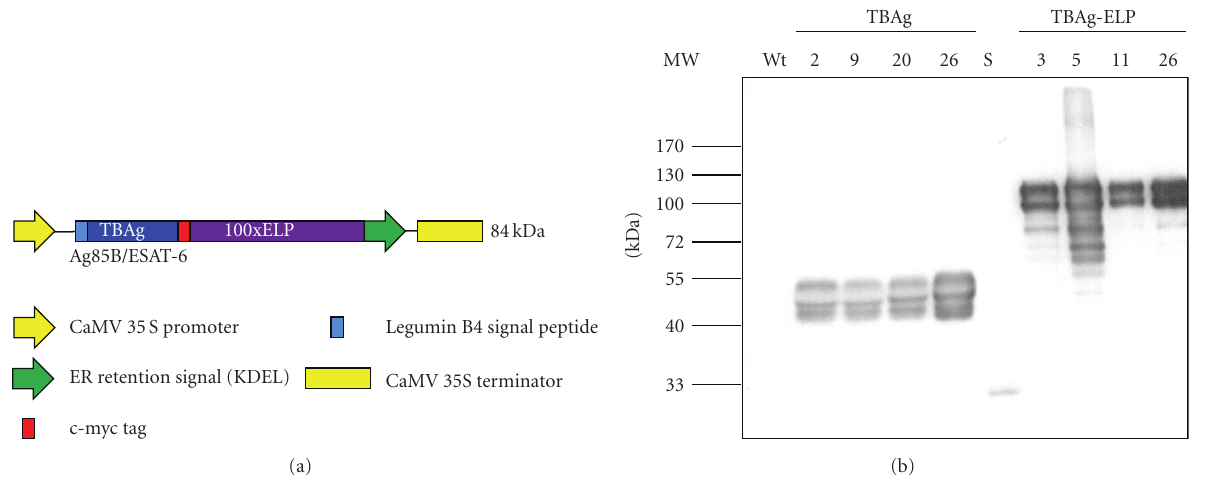
Figure 2: Production of plant-expressed TBAg-ELP fusion protein. (a) Diagrammatic representation of the TBAg-ELP expression cassette. Expression of the recombinant fusion protein was driven by the constitutive CaMV 35S promoter. Endoplasmic reticulum retrieval was mediated by a C-terminal KDEL tag and the c-myc tag was included to facilitate detection. ELP fusion consisted of 100 repeats of the pentapeptide VPGXG, where X was valine, glycine, or alanine (100xELP). (b) Accumulation increase of TBAg-ELP in transgenic tobacco plants. Western blot analysis of leaf extracts of individual T 0 plants expressing the transgene. Proteins were separated by reducing 10% SDS- PAGE, blotted, and immunodetected using an anti-c-myc antibody. Numbers designate the independent T 0 plants. The same amounts of TSP were loaded on the gel (15 μ g/lane). S: cmyc standard (15ng/lane); Wt: wild-type N. tabacum